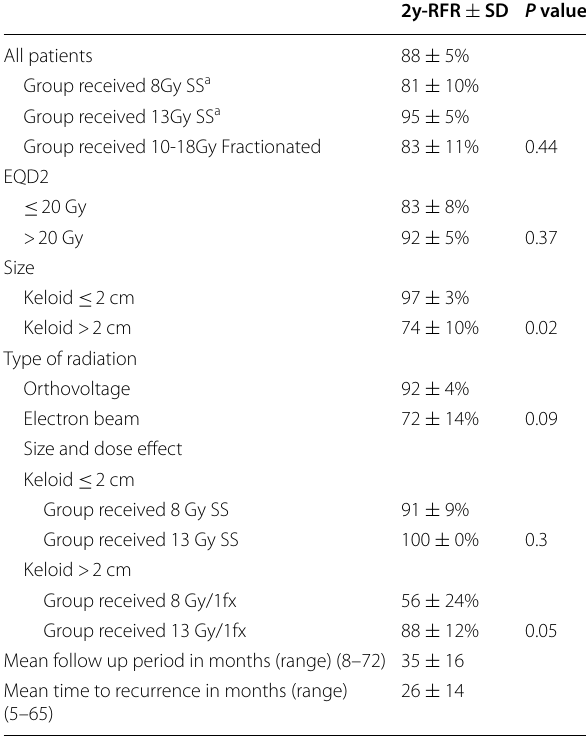
a SS single shot. Comparing patients of 8Gy SS and patients of 13Gy SS = separately is insignificant also with p value 0.2